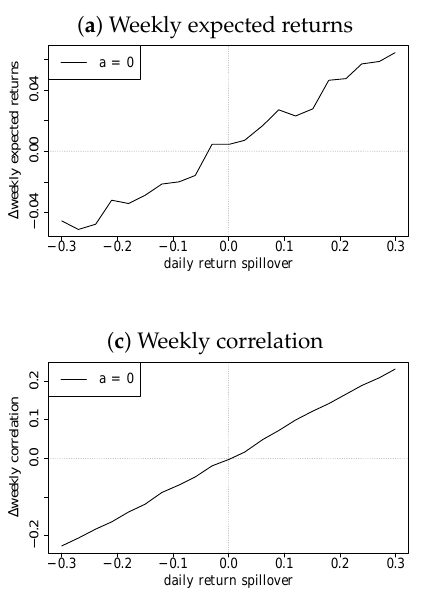
Figure 3. Effects of return spillovers on lower frequency assets’ characteristics. This figure presents the effects of daily return spillovers on expected returns ( a ), standard deviation of the spillover- receiving asset ( b ), and the return correlation between spillover-giving and spillover-receiving assets ( c ) at weekly level. We use “daily” and “weekly” for the illustration purpose; the results also apply to other relative “high” and “low” frequencies. Because of overlaps between lines, we only present the case with a = 0 in ( a , c ). The graphs for a = − 0.5 and a = 0.5 are qualitatively